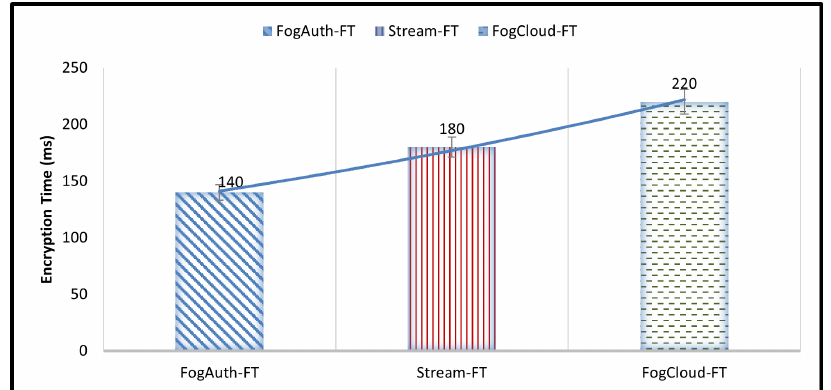
Figure 8. Encryption time block sizes of 256